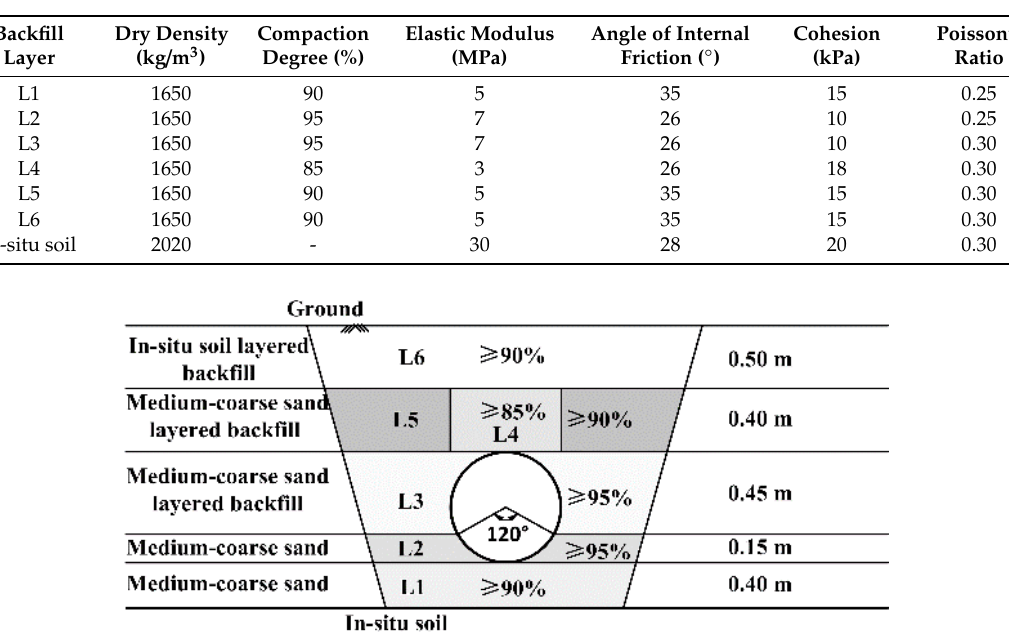
Table 4. Physical properties of the standard compacted backfill in numerical analysis.